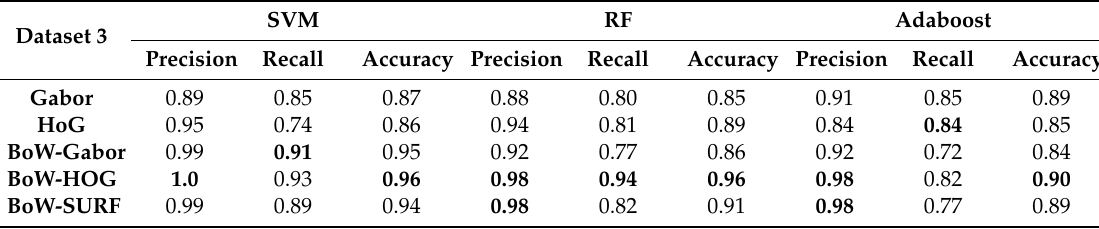
Figure 6. Samples of image patches in dataset 3: street view images. Table 5. Performance of feature descriptors when associated with different learning algorithms for dataset 3, comprising patches from street view images (training samples = 620, testing samples = 267).